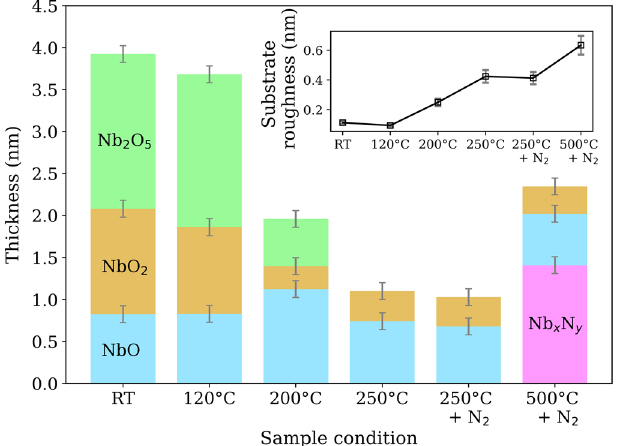
FIG. 4. Thickness and substrate roughness (inset) obtained by XRR in each step of the sample treatment.